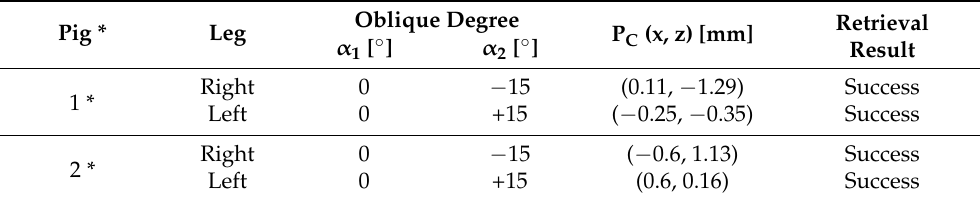
Figure 14. X -ray images from the in vivo experiment: ( a ) separation; ( b ) forward motion; ( c ) back- ward motion; ( d ) retrieval. Table 2. Calculated central position of the connecting part of the delivery catheter and the success rate of the retrieval of the UMR from the femoral arteries of the